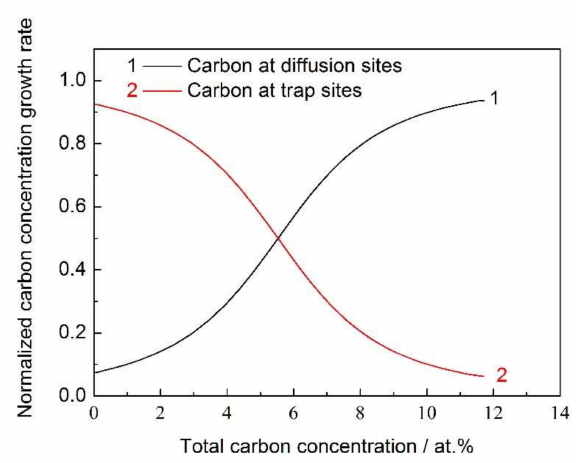
Figure 9. Normalized concentration growth rates of carbon at the diffusion sites and the trap sites vs. total carbon concentration.